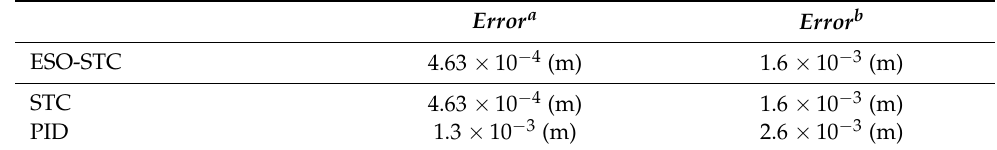
Table 1. Tracking performance of different control strategies.